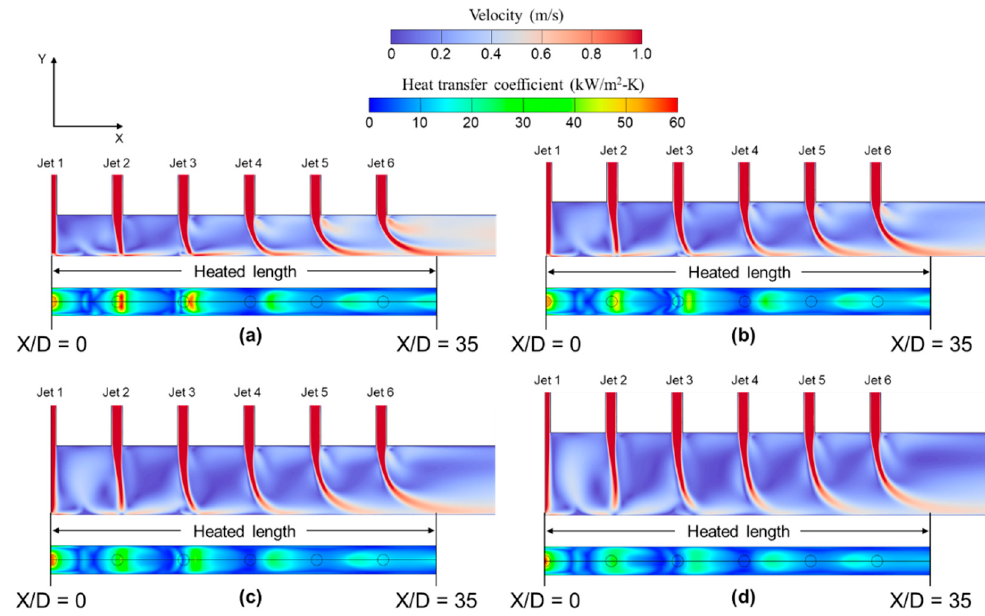
Figure 8. Velocity contours and wall heat transfer coefficient distributions at q ″ = 10 W/cm 2 and V jet = 1 m/s for ( a ) H ch = 3 mm; ( b ) H ch = 4 mm; ( c ) H ch = 5 mm; ( d ) H ch = 6 mm.